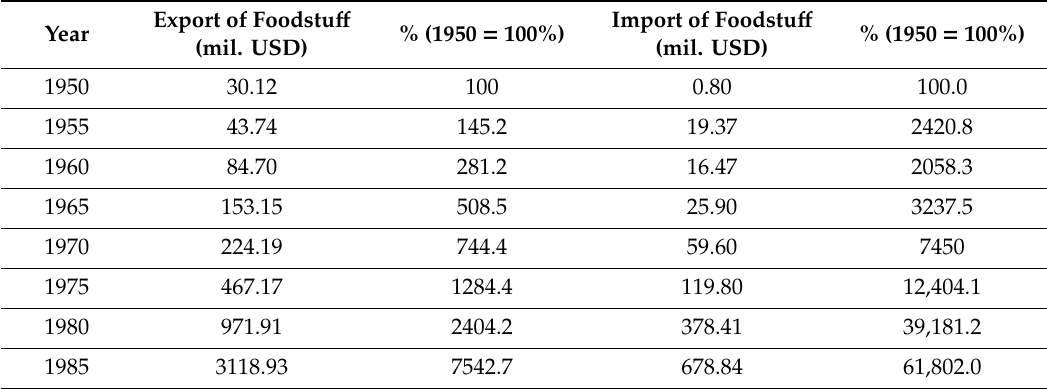
Table 1. The evolution of the value of exports and imports of foodstu ff s.